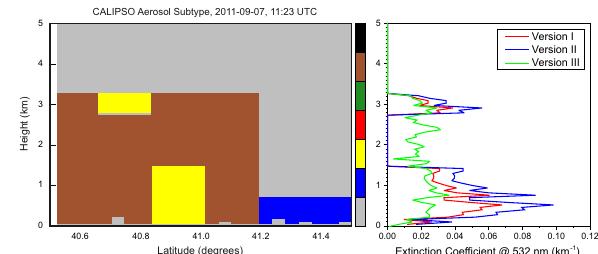
Fig. 6. Example of the averaging procedure followed for the three different versions of CALIPSO climatological products for 7 September 2011 at 11:23UTC. Left panel shows the CALIPSO aerosol subtype: clean marine (blue), dust (yellow), polluted con- tinental (red), clean continental (green), polluted dust (brown) and smoke (black). Right panel presents the corresponding averaged ex- tinction coefficient profiles at 532nm following the three different versions of CALIPSO climatological